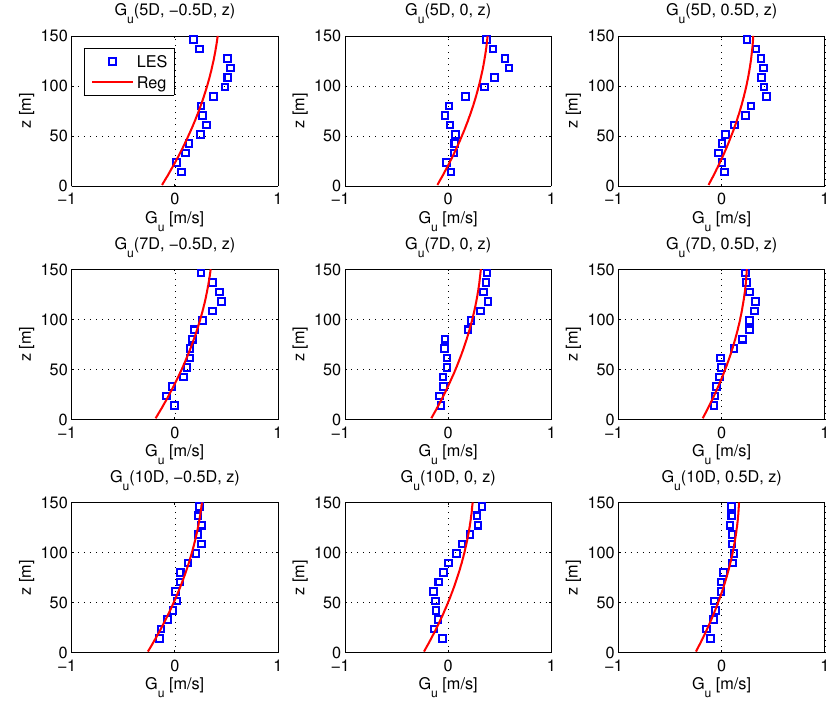
Figure 21. Spatial variation of G u : LES versus regression-based